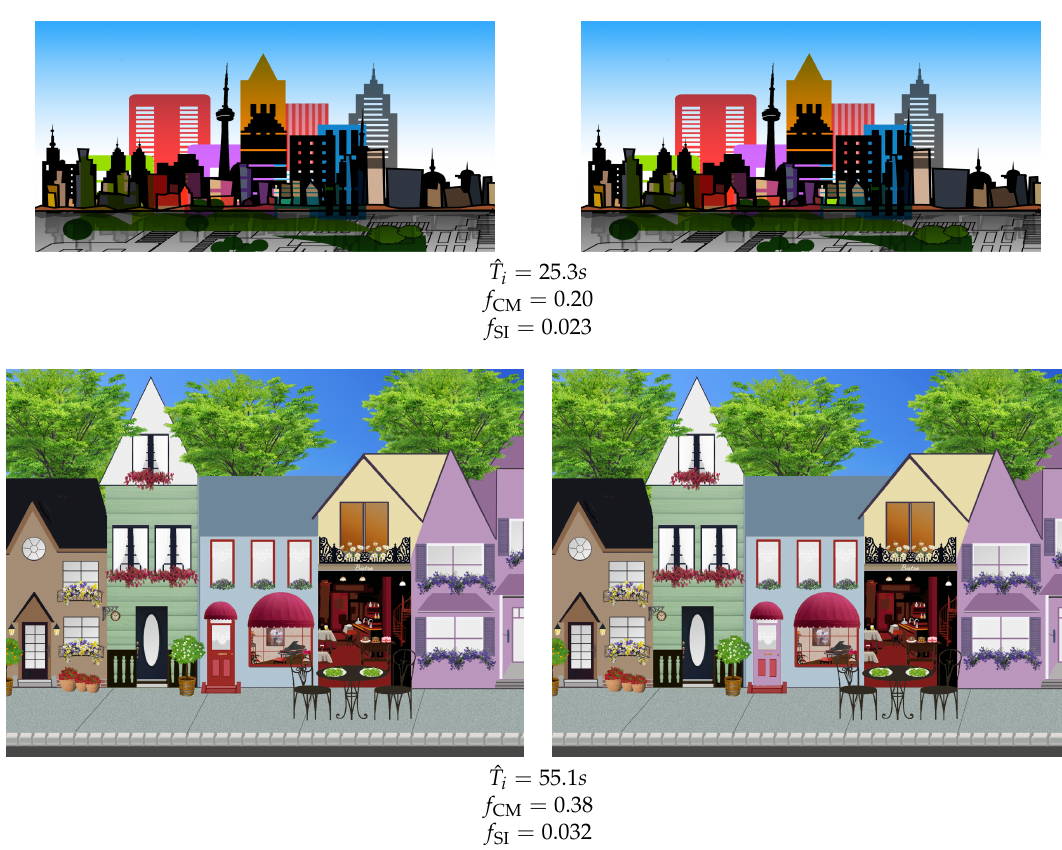
Figure 7. Image pairs corresponding to the best (top) and worst (bottom) prediction of mode detection times (in terms of root mean square error). Solution, top: the green rectangle just at the foot of the red building with vertical stripes, bottom: the central building’s